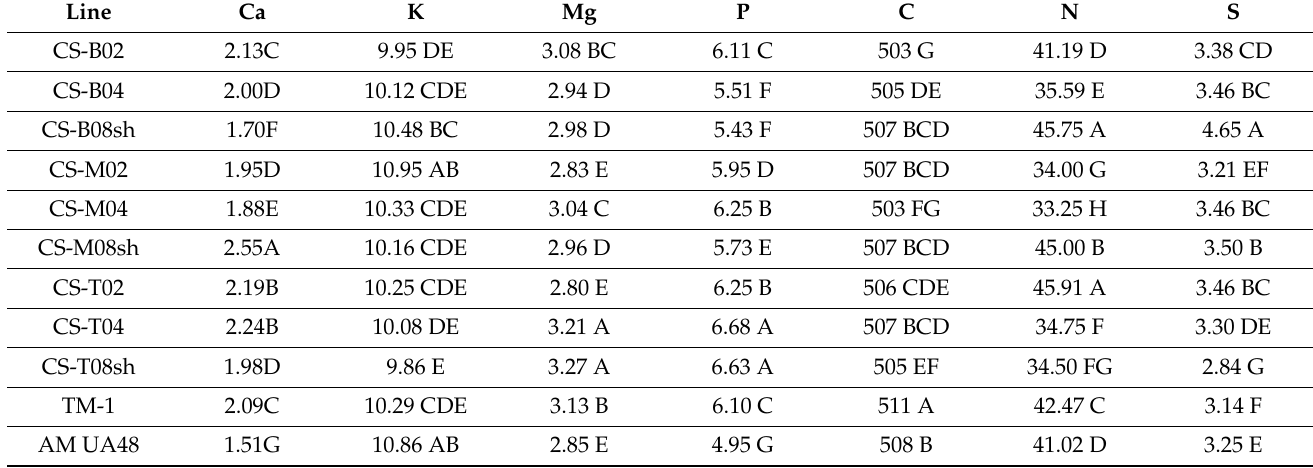
Table 3. Experiment 2: Effects of cotton chromosome substitution (CS) on cottonseed macronutrient concentrations (g kg − 1 ). The experiment was conducted in 2014 in Mississippi State (Starkville, MS,